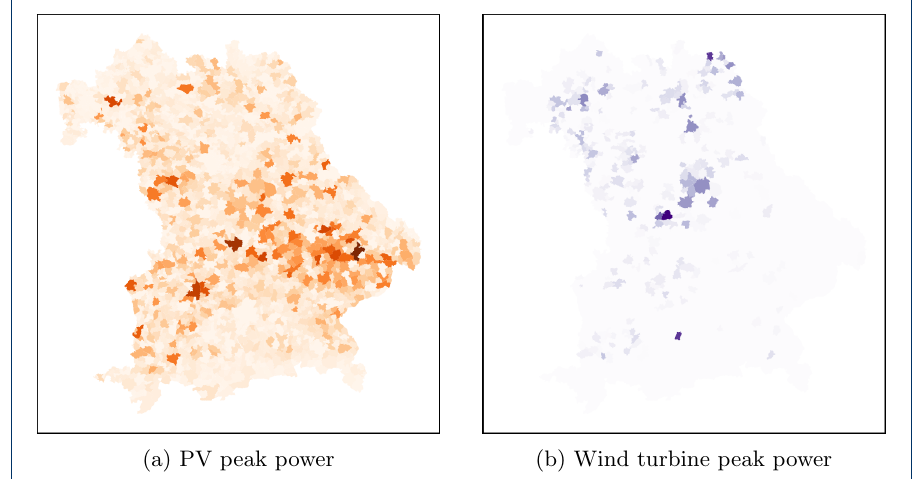
Figure 1: PV and wind peak power installations per municipal in